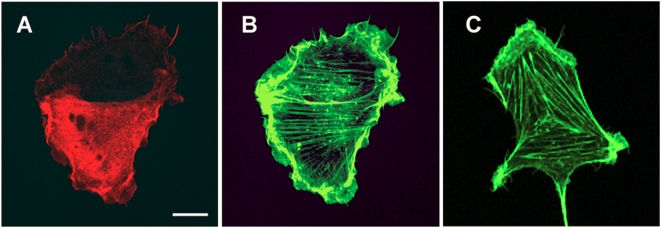
The actin cytoskeleton is unaffected by the p14 endodomain.QM5 cells were transfected with the FLAG-tagged p14 endodomain, and immunostained using anti-FLAG antibody and fluorescently tagged secondary antibody (A). F-actin was visualized by staining with FITC-phalloidin (B,C). A transfected cell expressing the FLAG-tagged p14 endodomain and an adjoining cell either not transfected or expressing undetectable levels of the endodomain ((A), lower and upper cells, respectively) exhibited similar arrangements of F-actin, as detected using FITC-phalloidin (B), and the same actin organization was observed in mock-transfected cells (C). Scale bar = 10 µm.